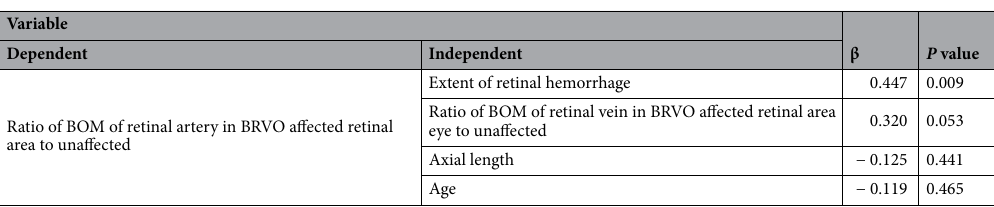
β P valueDependent Independent